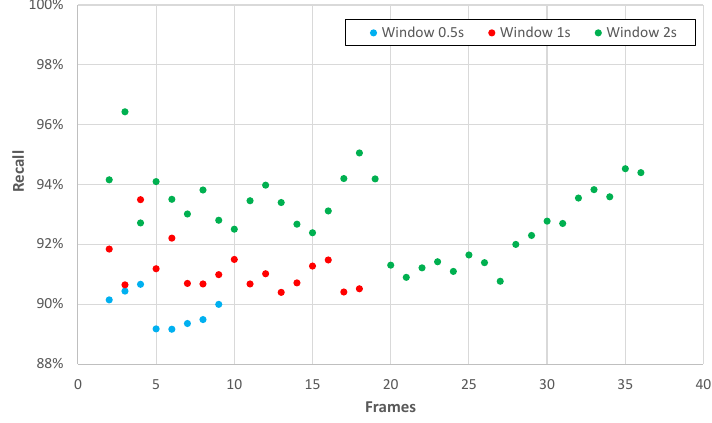
Figure 4. Exhaustive search